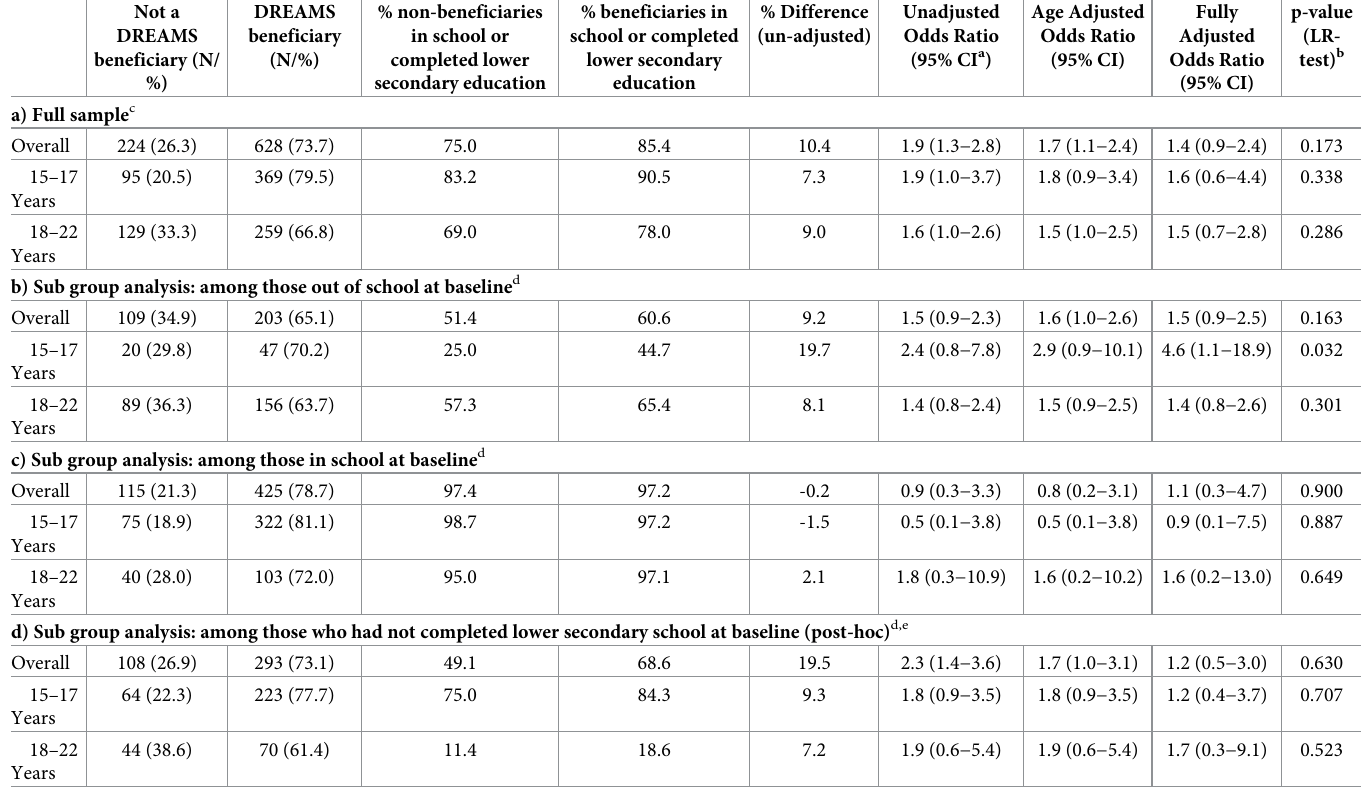
Table 4. (a, b, c, d) Association between DREAMS and educational attainment �� among AGYW aged 15–22 years using multivariable logistic regression, overall and stratified by age at enrolment. Not a DREAMS beneficiary (N/